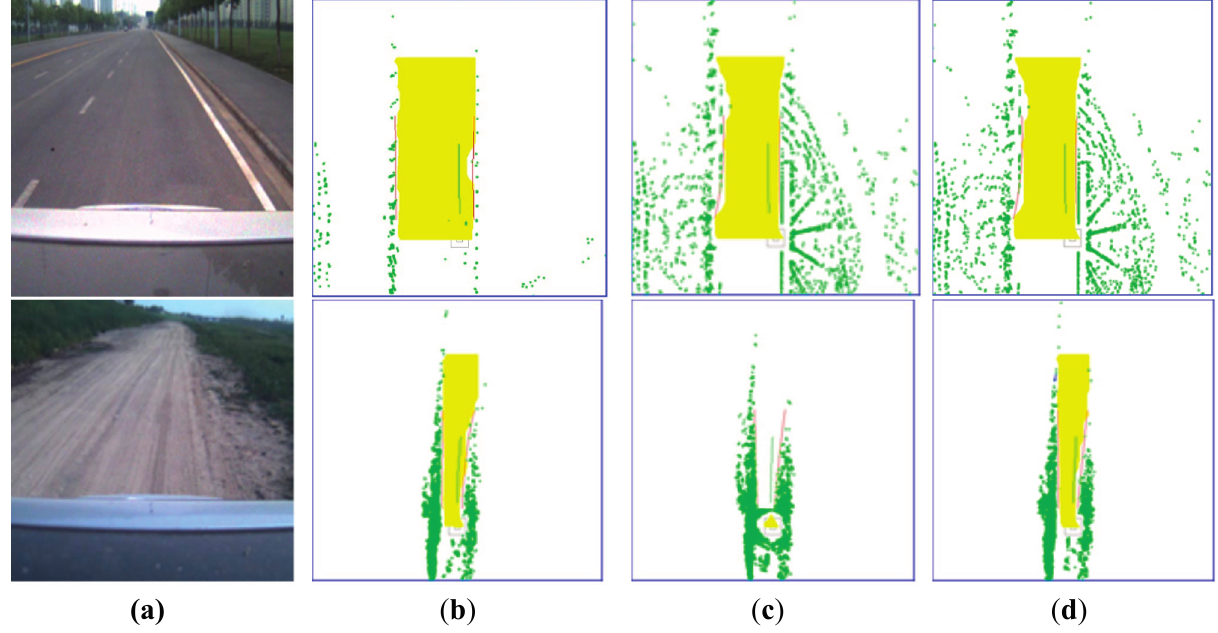
Figure 8. Scene where the vehicle parked along the road side was designated as the road curb. ( Left column ) Original image taken by camera; ( Middle column ) Original grid map obtained by Velodyne LIDAR; ( Right column ) Ground segmentation and curb fitting results.